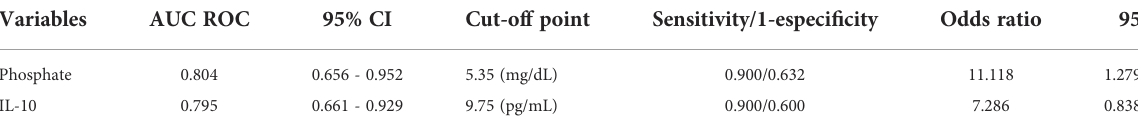
TABLE 2 Area under the ROC curve and odds ratio in presenting post-covid syndrome.